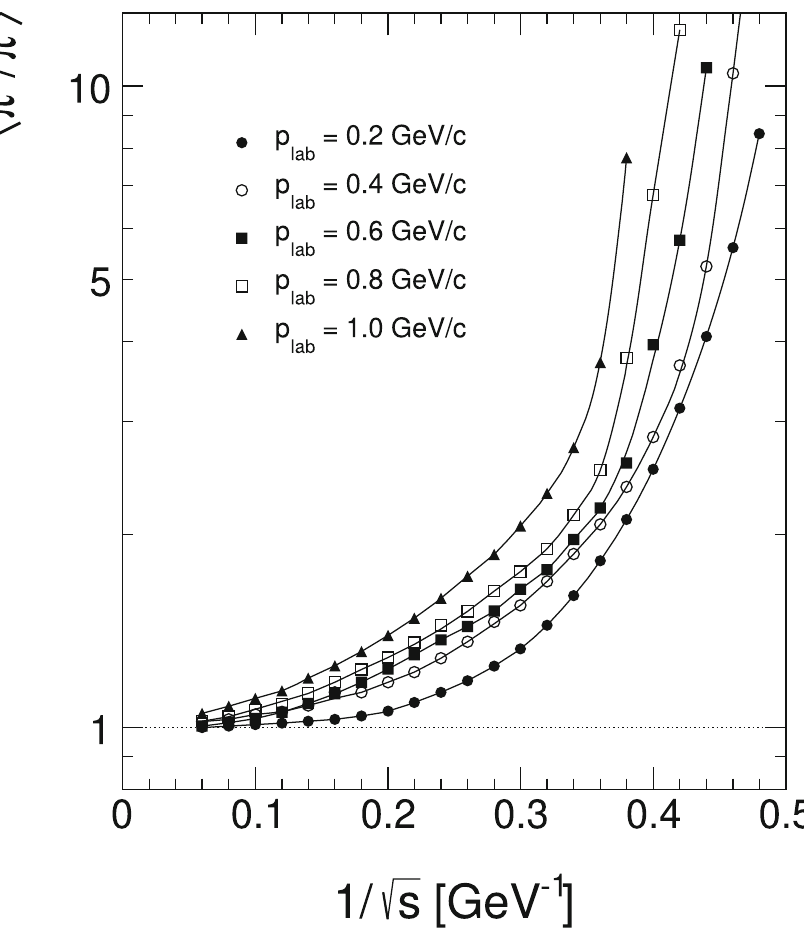
Fig. 166 (cid:4) π + /π − (cid:5) as a √ s for five values function of 1 / of p lab between 0.2 and 1.0 GeV/c. The full lines are hand interpolations through the data points for p+C interactions in the target frame